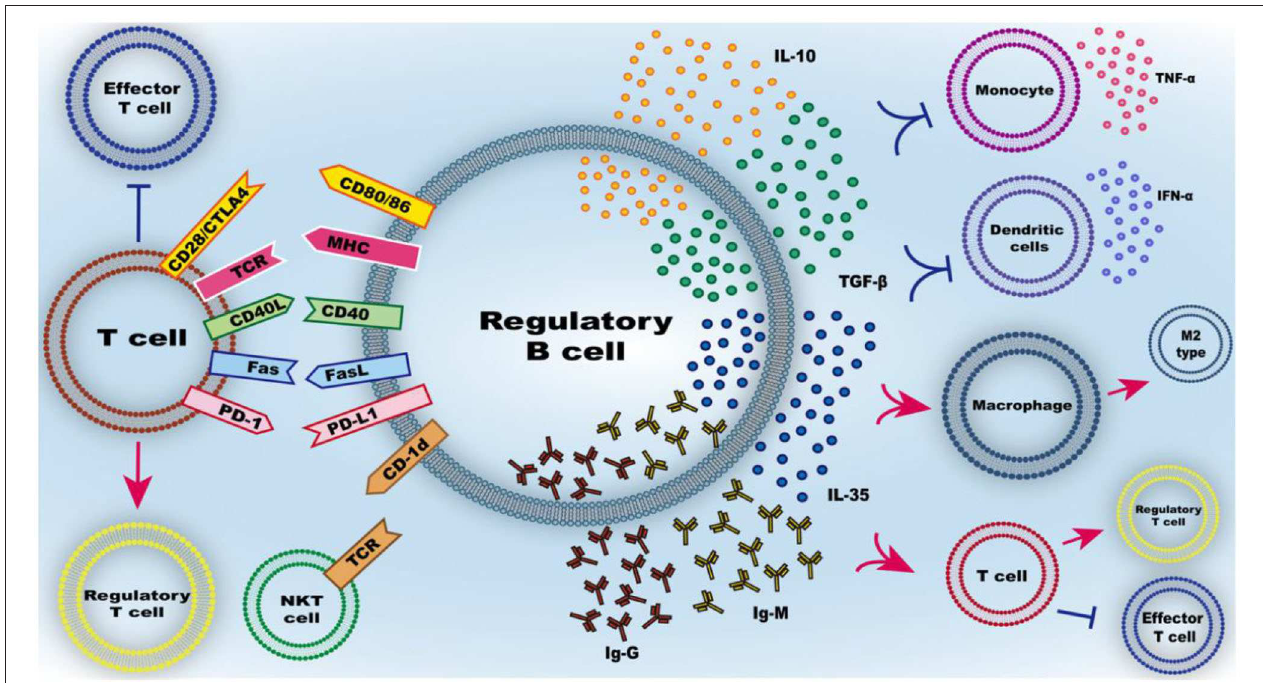
FIGURE 3 | Function of Breg cells. The mechanism of Breg cell inhibitory effect mainly includes the secretion of inhibitory mediators and the inhibitory effect of intercellular contact. IL-10, as the main secreted inhibitory cytokine of regulatory B cells, has a variety of effects such as inhibiting the release of pro-inflammatory cytokines from immune cells, inhibiting the inflammatory differentiation of macrophage/microglia and promoting the conversion of T cells to regulatory T cells rather than effector T cells. Similarly, TGF- β , IL-35, IgG, and IgM can also regulate the differentiation of T cells into regulatory T cells. Membrane-bound molecules at the interface between regulatory B cells and T cells include CD80/86, CD40, MHC, FasL, PD-L1, and CD-1d, can regulate the differentiation of T cells into regulatory T cells and activate natural killer T (NKT) cells with suppressive